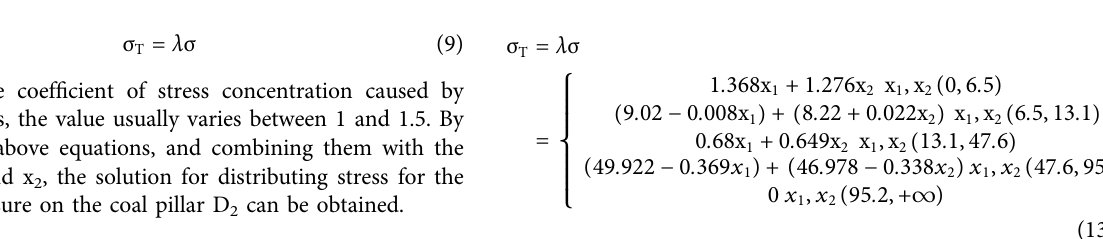
FIGURE 10 | Theoretical analysis model of the coal stress structure fi eld in the area of the goaf islands on both sides of the excavated zone.